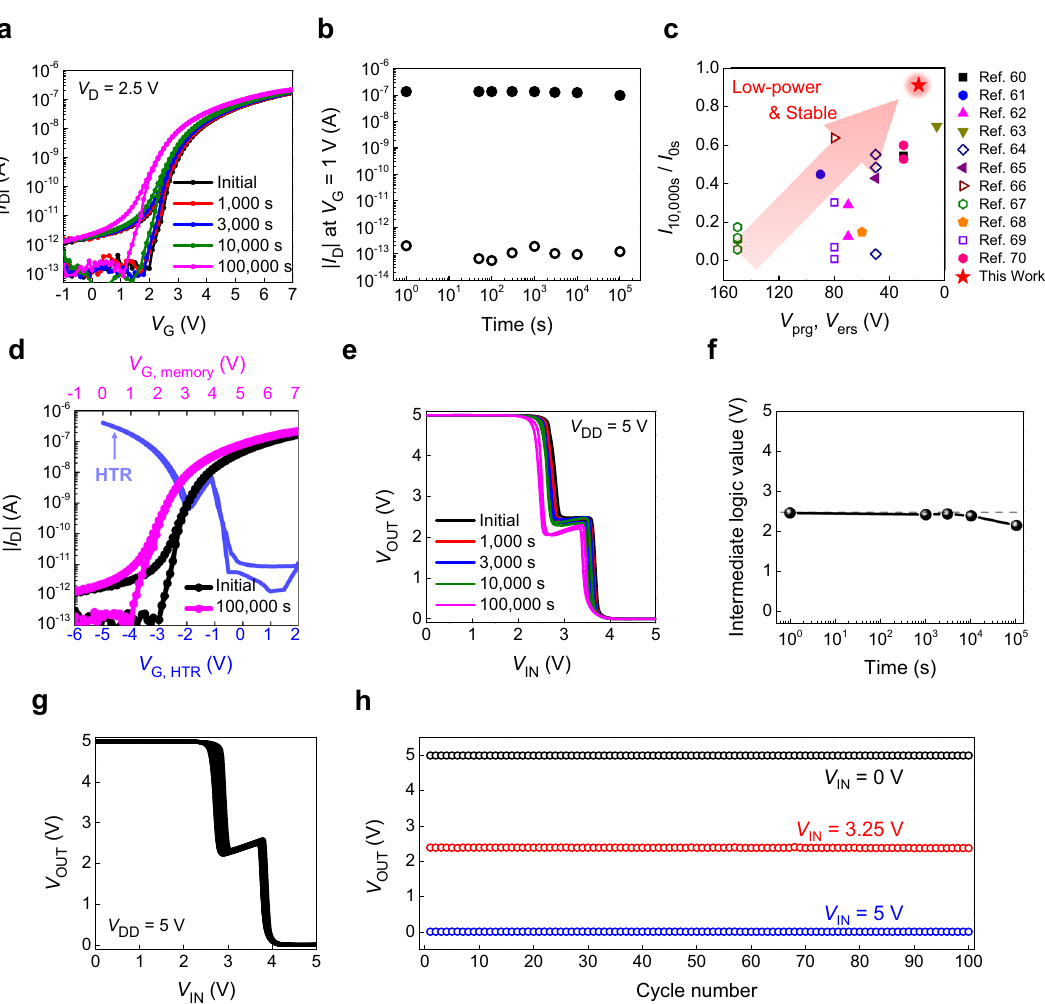
Fig. 6 Stability of the three-dimensional (3D) ternary logic inverter (T-inverter). a The change in transfer characteristics of the fl ash memory according to time after the optimum programming state (programming voltage ( V prg ) = + 19 V) and b drain current ( I D ) at gate voltage ( V G ) = 1 V and I D = 2 V versus time in the programming (open symbol) and erasing (closed symbol) states. c The comparison of the retention characteristics and programming voltage/erasing voltage ( V prg / V ers ) of the fl ash memory in this study to those based on polymer dielectrics in the previous reports. d The change in transfer curves of the fl ash memory according to time and the transfer curve of the heterojunction transistor (HTR). e The change in voltage transfer characteristics (VTCs) and f intermediate logic value of the 3-dimensional (3D) ternary logic inverter (T-inverter) according to time. g The VTCs of 100 consecutive sweeps of the 3D T-inverter with the optimum programming states, and h output voltage ( V OUT ) values at input voltage ( V IN ) = 0, 3.25, and 5 V extracted from each